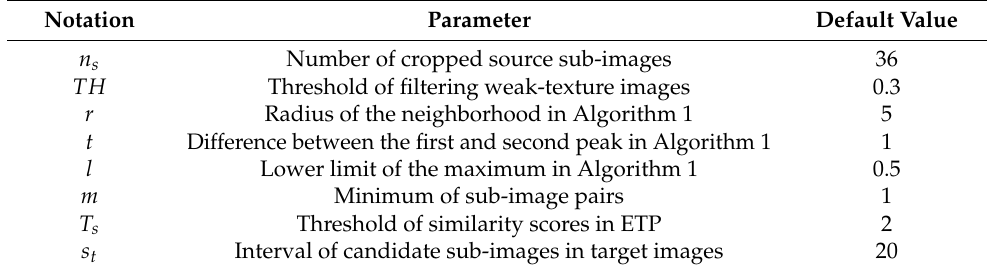
Table 4. The experimental parameter